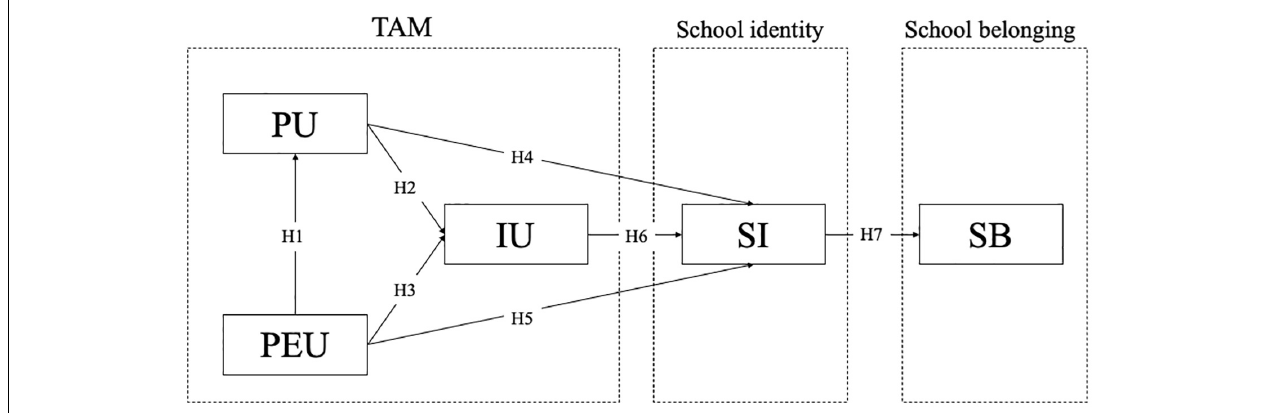
FIGURE 1 | Hypothesis model of the relationship between the use of FACS, school identity, and school belonging. PU, Perceived usefulness; PEU, Perceived ease of use; IU, Intention to use; SI, School identity; SB, School belonging.